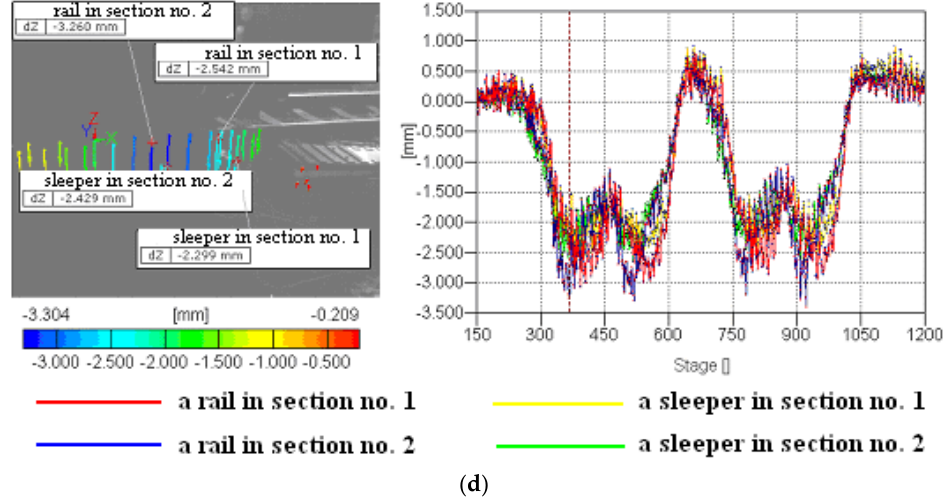
Figure 6. Decreasing of cross-section no. 2—loads from the succeeding axles on cross-section no. 2 (a scheme from Figure 3) (Pontos viewer). A deflection of the rail and the sleeper due to induced irregularity in the railway track during a deflection of the cross-section no. 2; ordinate axis-a deflection of rail and sleeper; abscissa axis-consecutive measurements every 0.005 [s]; one step of stage = 0.005 [s]: ( a ) with an irregularity f 0 = 0 mm in track; ( b ) with an irregularity f 0 = 1 mm in track; ( c ) with an irregularity f 0 = 2 mm in track; ( d ) with an irregularity f 0 = 3 mm in